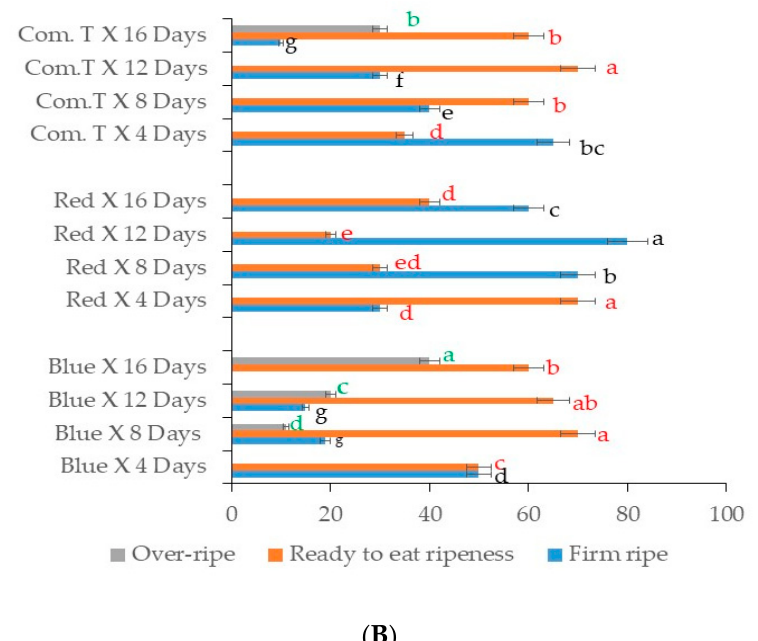
Figure 7. ( A ) Influence of LED light treatment on ripening in avocado cultivar Fuerte. ( B ) Influence of LED light treatment on ripening in avocado cultivar Hass. Fruit were exposed to blue or red LED light for 6 h per day during storage and left at 25 °C for 2 days after storage. Mean values for each bar were calculated based on 100 fruits for each treatment. Bars with similar letters were not significantly different at p < 0.05 according to LSD. Blue, blue LED light; Red, red LED light; Com. T, commercial treatment.